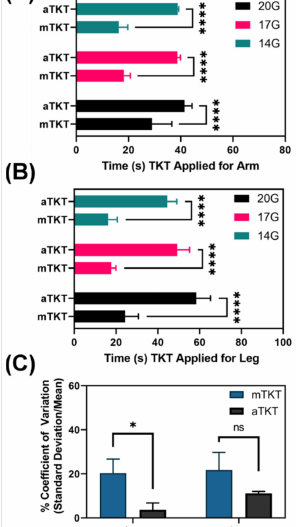
Figure 6. Comparison of TKT application time for aTKT and mTKT. Time for TKT application for both the aTKT and mTKT using the synthetic ( A ) arm and ( B ) leg test setup. aTKT application time was determined by closed loop algorithm while mTKT application was determined by qualitative, visual inspection of hemorrhage stop. Average results are shown for three hemorrhage rates ( n = 12). Significant differences between application times were determined by two-way ANOVA, post-hoc Sidak’s test. ( C ) Coefficients of variation for the arm and leg TKT application time for the aTKT and mTKT. Coefficient of variation was calculated as the standard deviation relative to the average for each data set ( n = 3). Significant differences between application times were determined by unpaired t -test (*, p < 0.05; ****, p < 0.0001; ns = not significant). Error bars denote standard